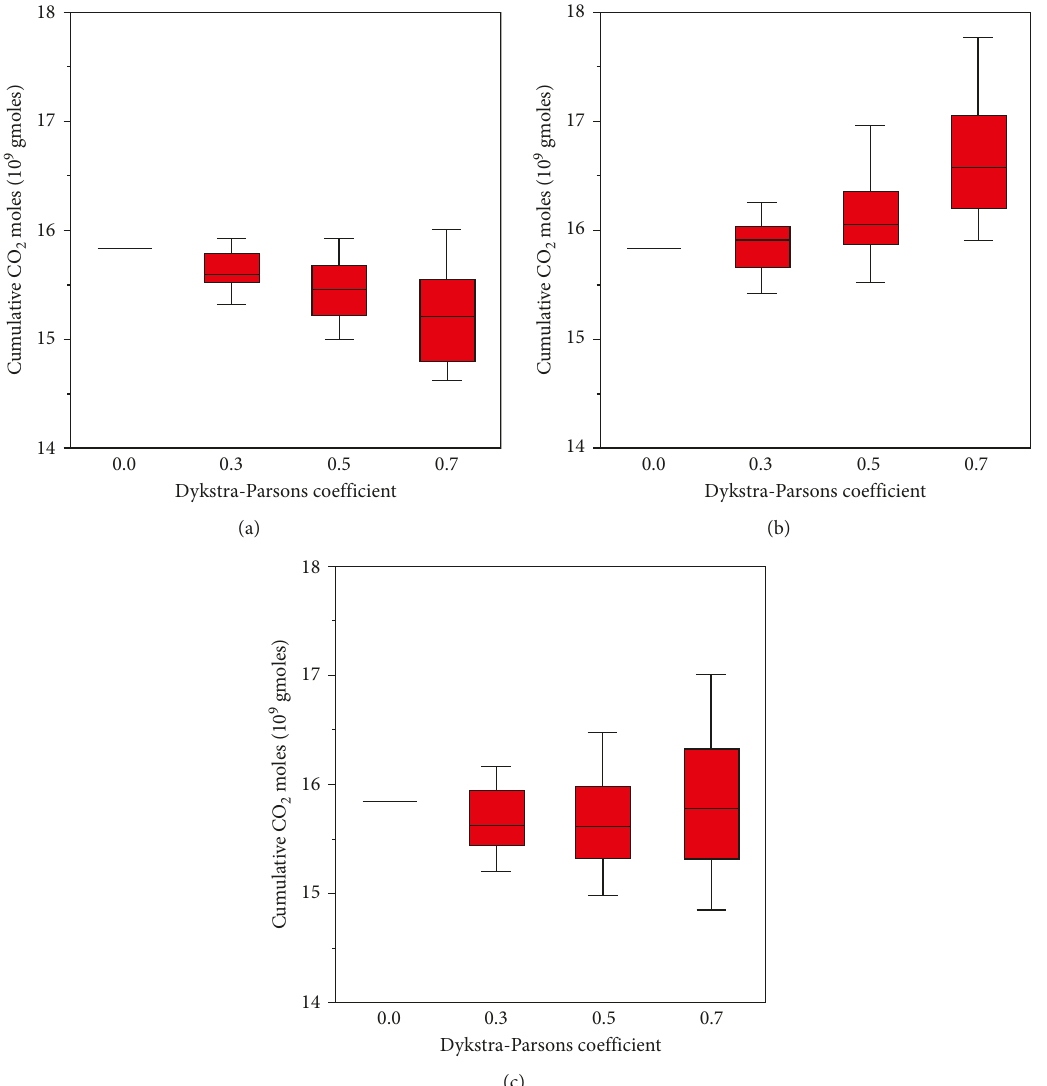
Figure 7: Box-whisker plots of sequestered CO 2 in aquifer after 10-year injection: Cases A, B, and